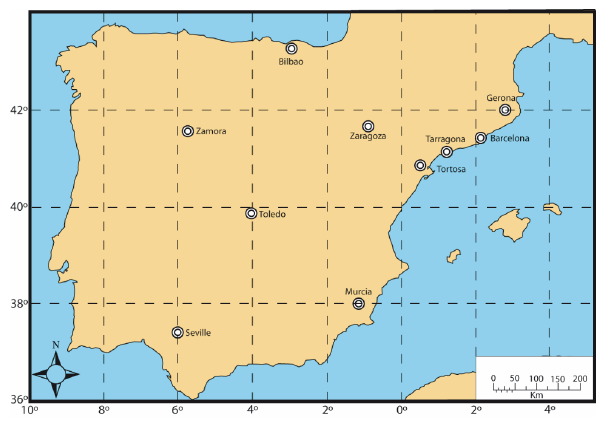
Fig. 1. Location of the rogation series used in this manuscript.